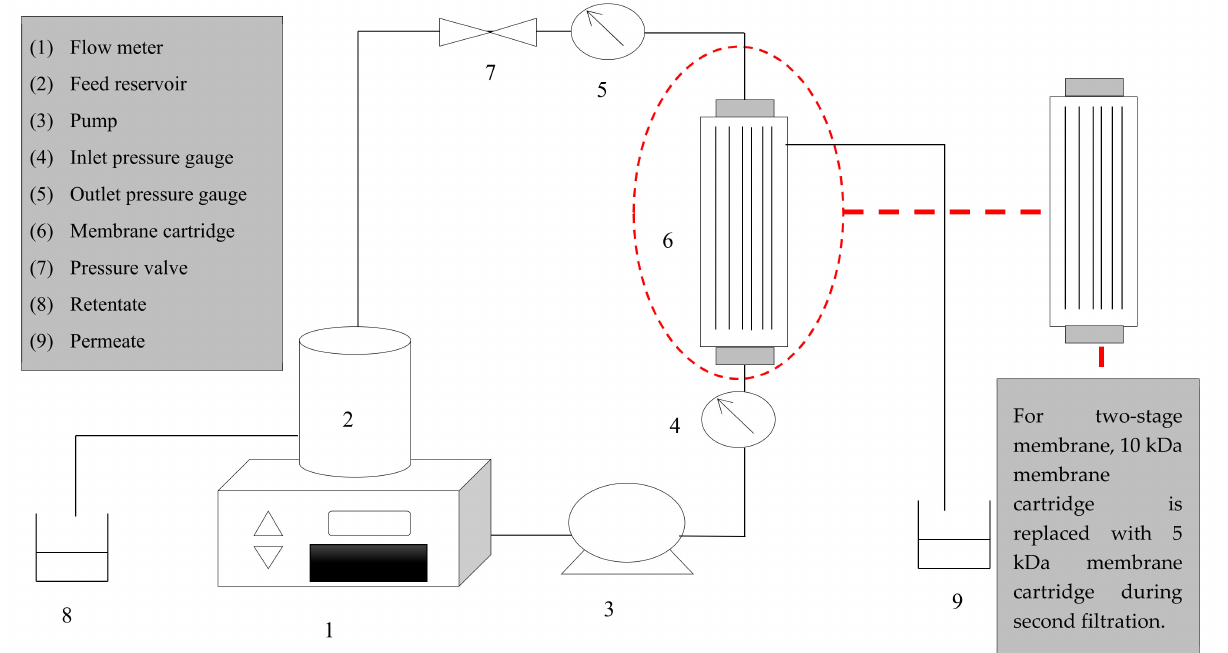
Figure 1. Schematic diagram of cross-flow ultrafiltration